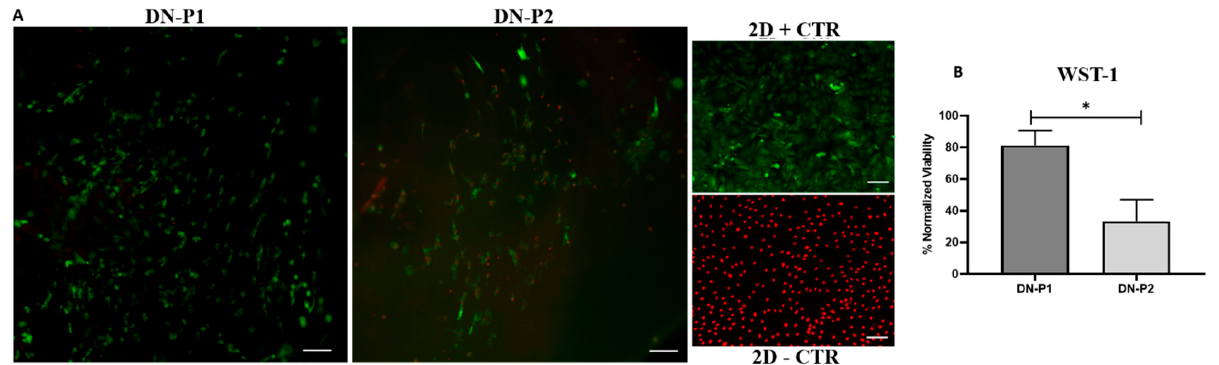
Figure 8. Representative qualitative and quantitative panel of Live & Dead and WST-1 assay of ADMSC-reseeded decellularized rat sciatic nerves. ( A ) Live & Dead (L/D) analysis. Green cells are alive while the red ones are dead. Scale bar 50 µm. ( B ) WST-1 analysis, normalized viability to 2D + CTR expressed in percentage. * indicate statistically significant differences between the two decellularization protocols ( p < 0.05).